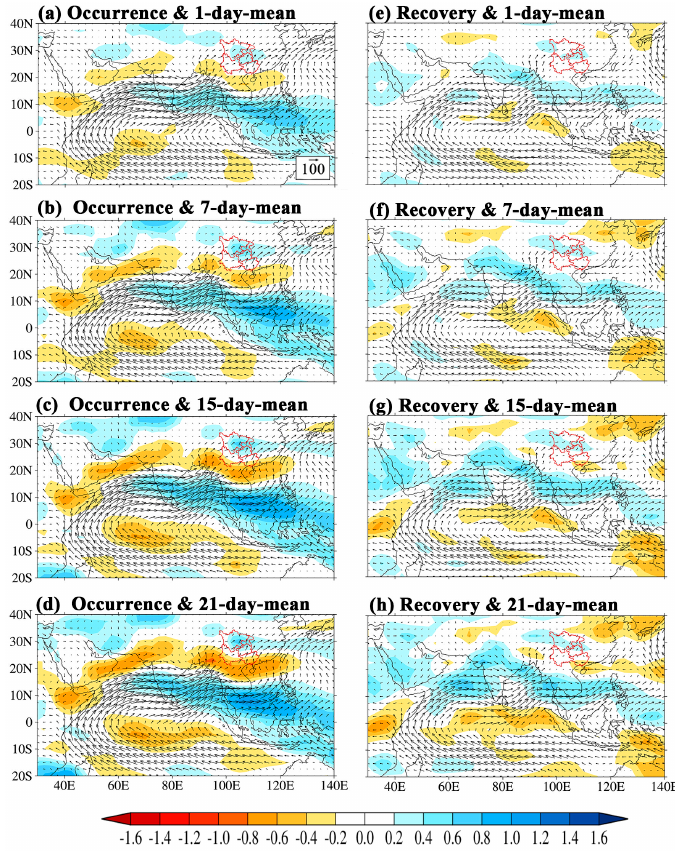
Figure 13. Composite of vertically integrated water vapor transport (WVT) and different duration running mean zonal standardized anomalies (SA) for drought: ( a – d ) occurrence; and ( e – h ) recovery phases. Vectors represent WVT, whereas shadows represent SA. The unit of WVT is kg·m − 1 ·s − 1 . The eastern direction of transport is positive.